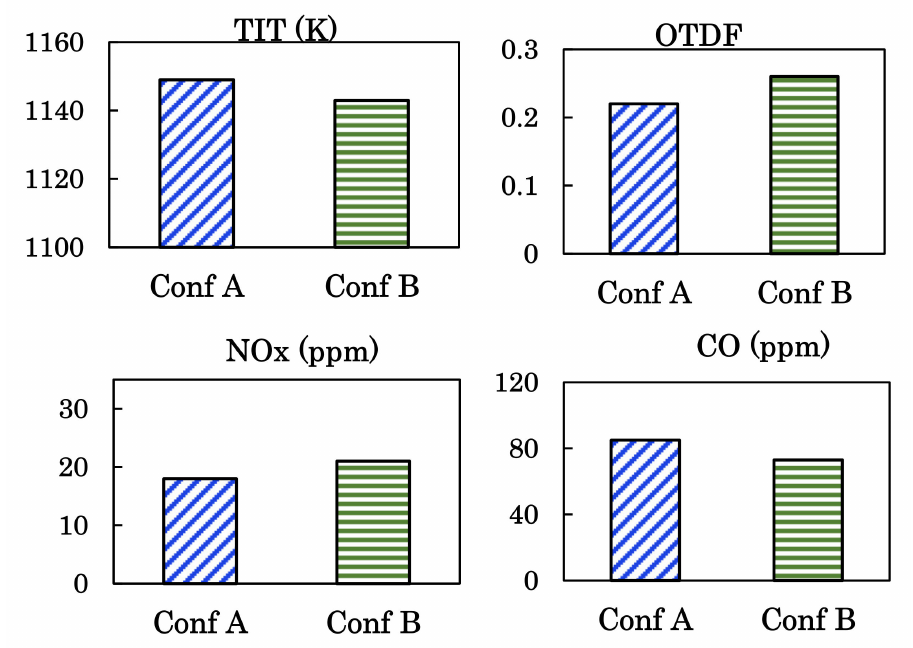
Figure 13. TIT, OTDF, and emissions